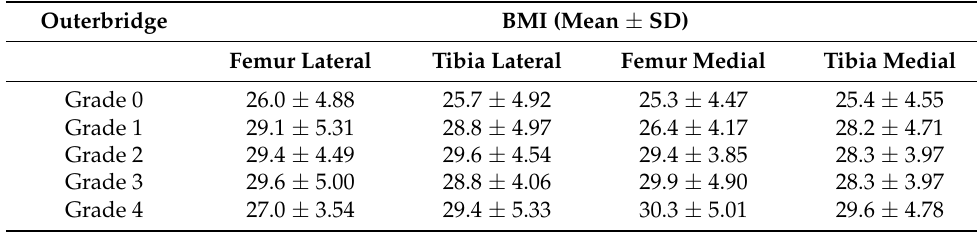
Table 3. BMI for Outerbridge scale.